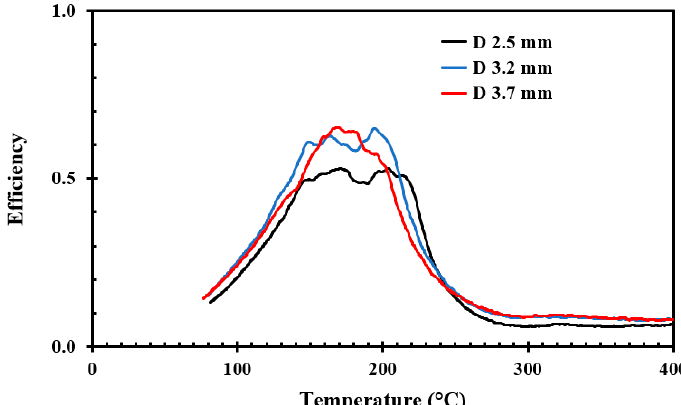
Figure 7. Cooling efficiency for pure water droplets with 25 cm impingement height for 30° inclination and various droplet diameters. Droplet speed 2.2 m/s.